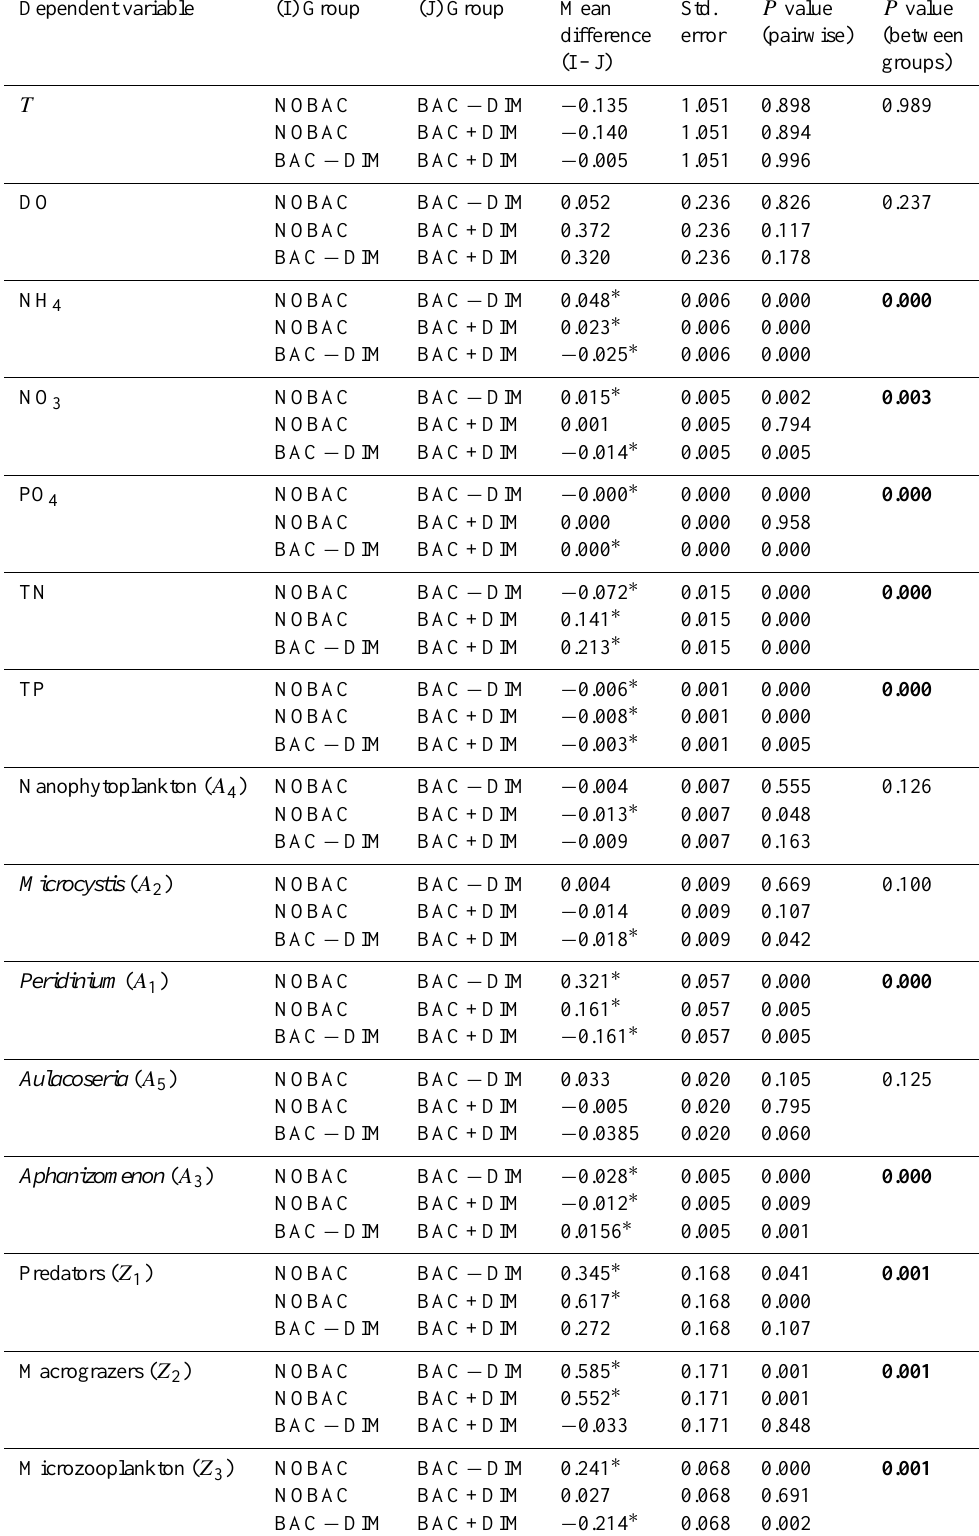
Table 5. Statistical analysis of water quality variables in the three microbial loop configurations by ANOVA and Multiple